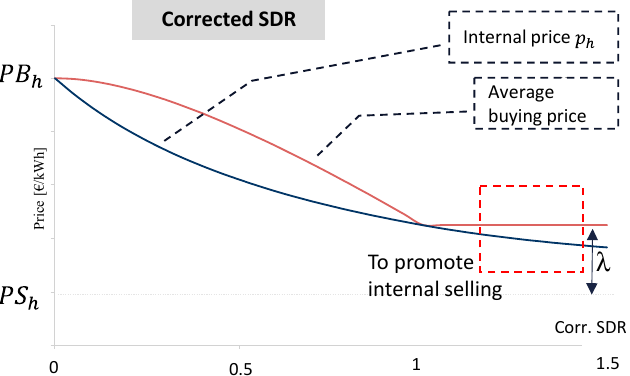
Figure 6. Relationship between p h , PS h , PB h , λ with the corrected SDR pricing.